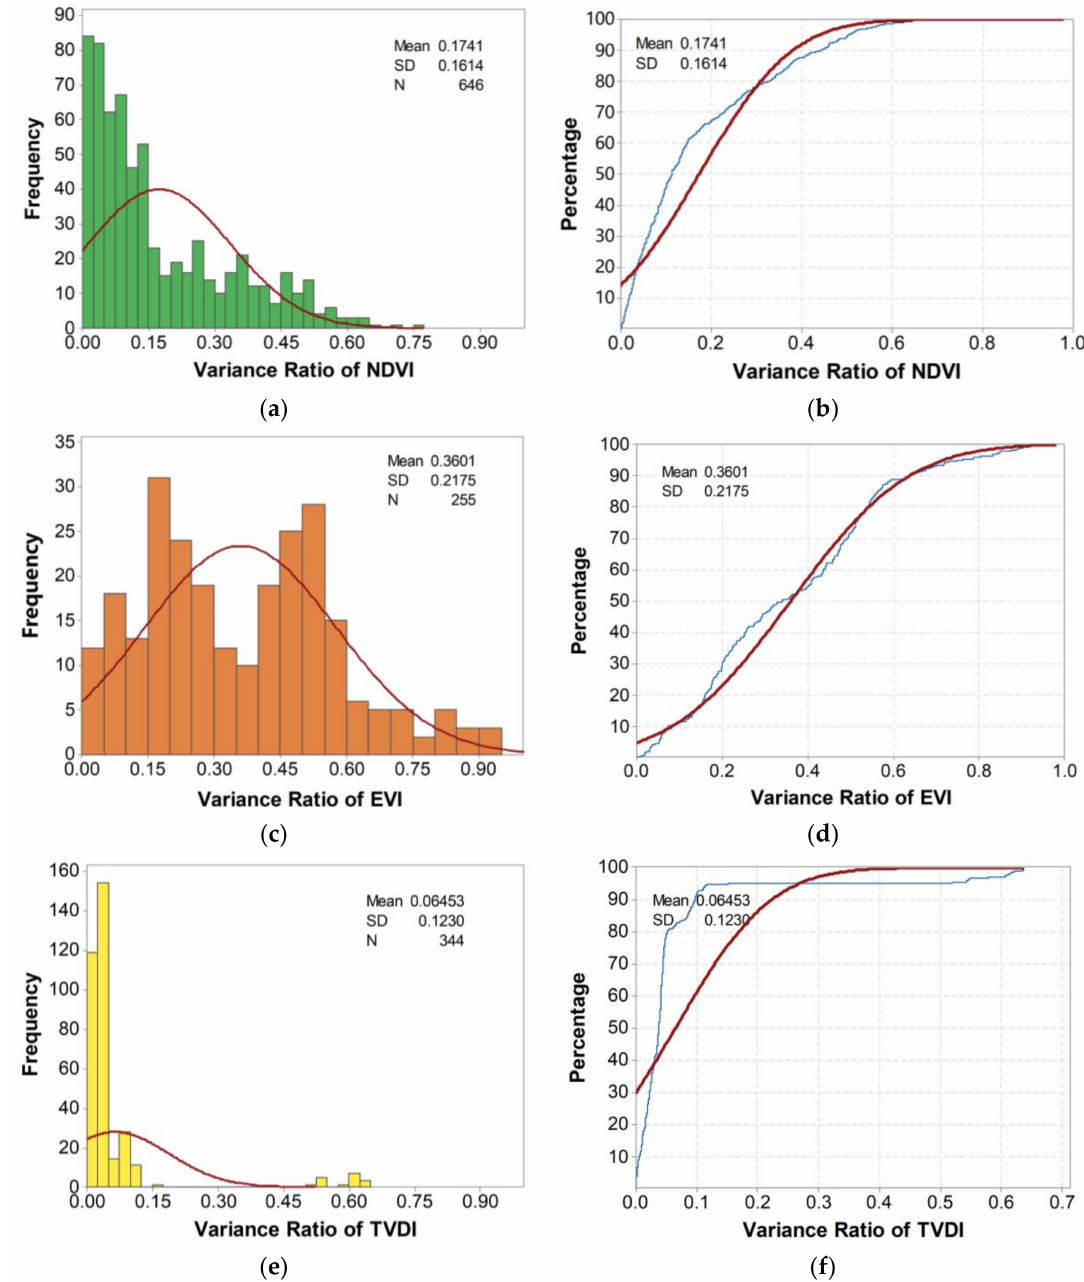
Figure 3. Probability density and cumulative probability function ( a ) PDF for NDVI; ( b ) CDF for NDVI; ( c ) PDF for EVI; ( d ) CDF for EVI; ( e ) PDF for TVDI; ( f ) CDF for TVDI. It can be seen from Figure 4 that the NDVI and EVI variance ratio values of NW, SW, and HJ are close and significantly higher than the TVDI variance ratio values. However, the high NDVI variability of the AP and YR regions is greater than EVI, and still significantly higher than the TVDI variance